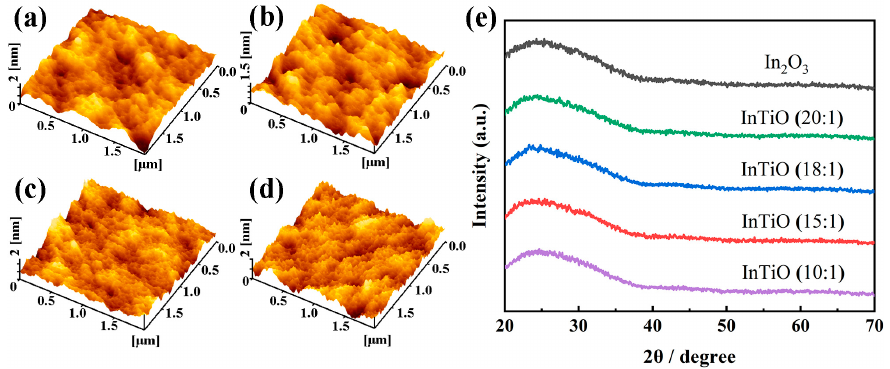
Figure 2. AFM images of ( a ) 20:1, ( b ) 18:1, ( c ) 15:1, ( d ) 10:1 InTiO thin films, and ( e ) XRD